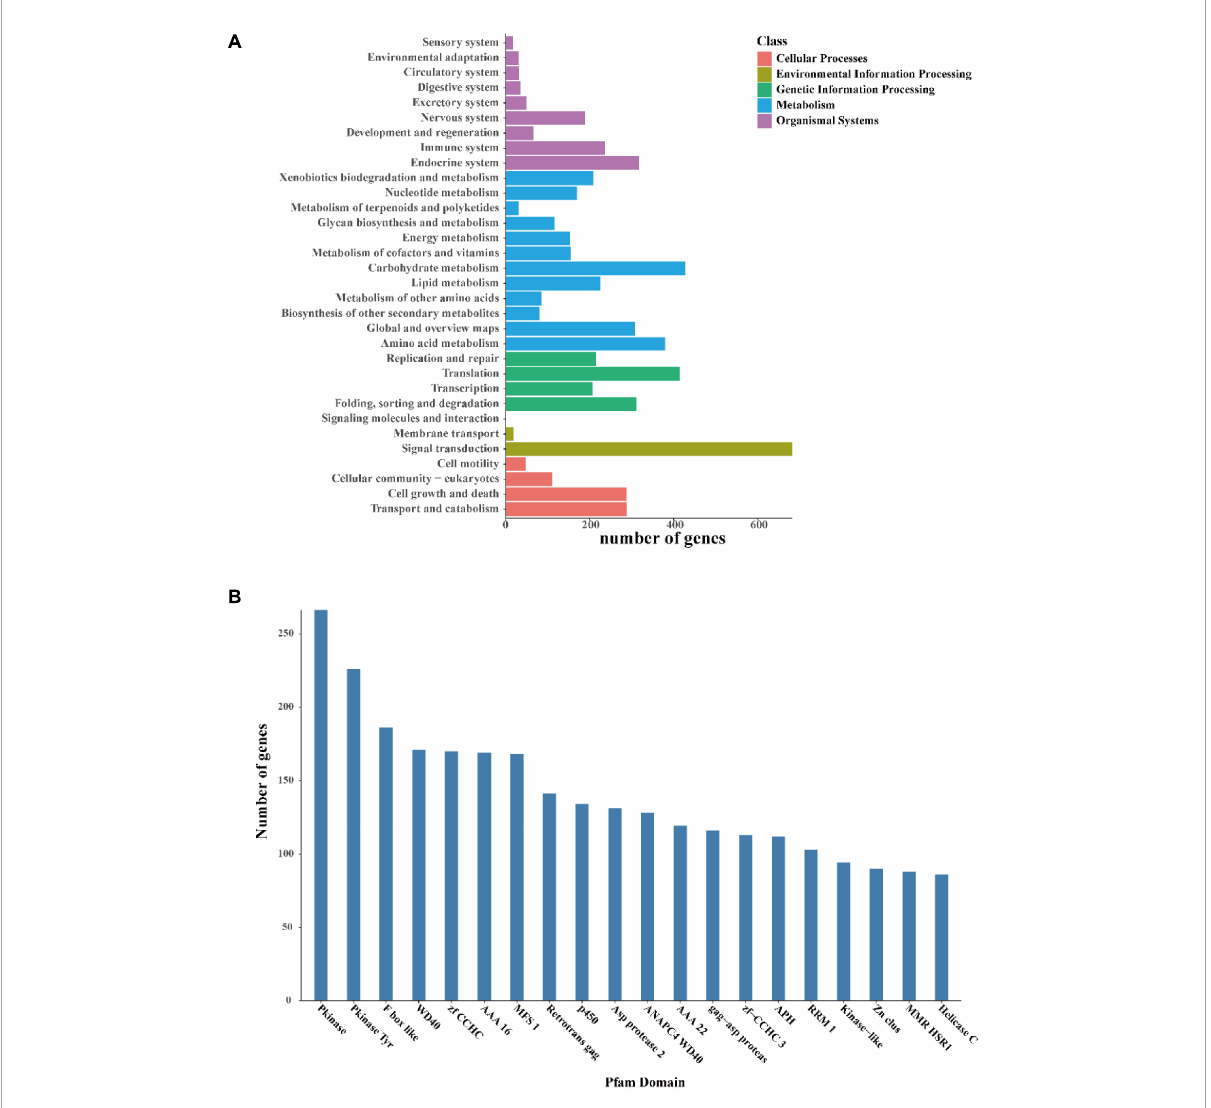
FIGURE6 Functional annotation of the I. hispidus genome. (A) KEGG Pathway functional classification diagram. (B) Pfam functional annotation classification statistics